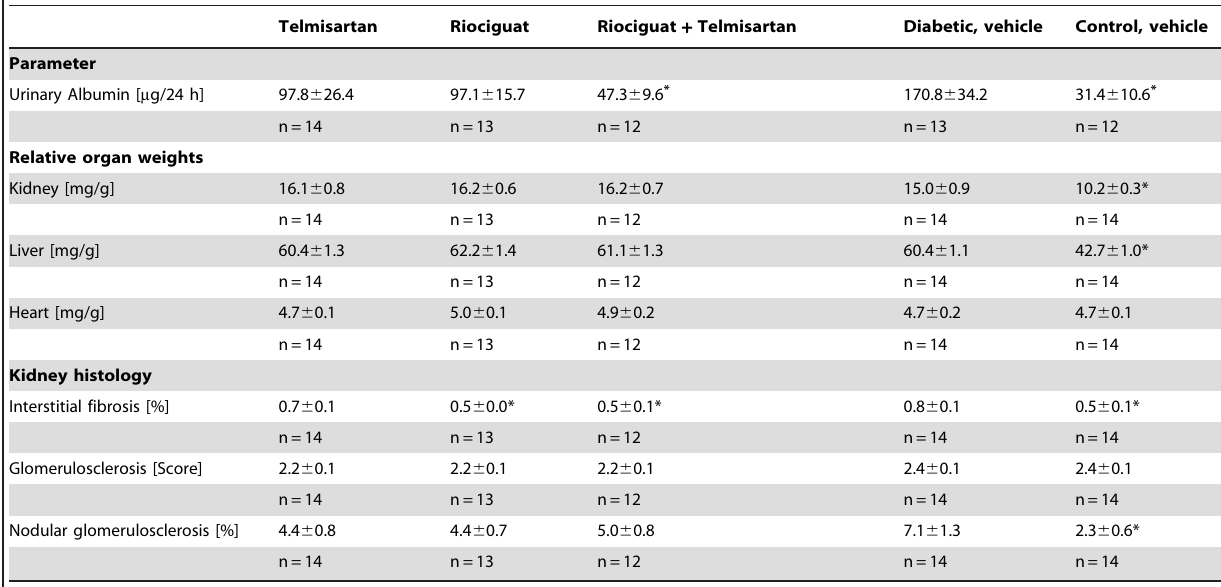
Table 2. Final urinary albumin as well as organ weights and histology of diabetic mice after 11 weeks of treatment with riociguat (3 mg/kg/d), telmisartan (1 mg/kg/d), riociguat and telmisartan (3 mg/kg/d and 1 mg/kg/d) or vehicle and of non-diabetic control mice,